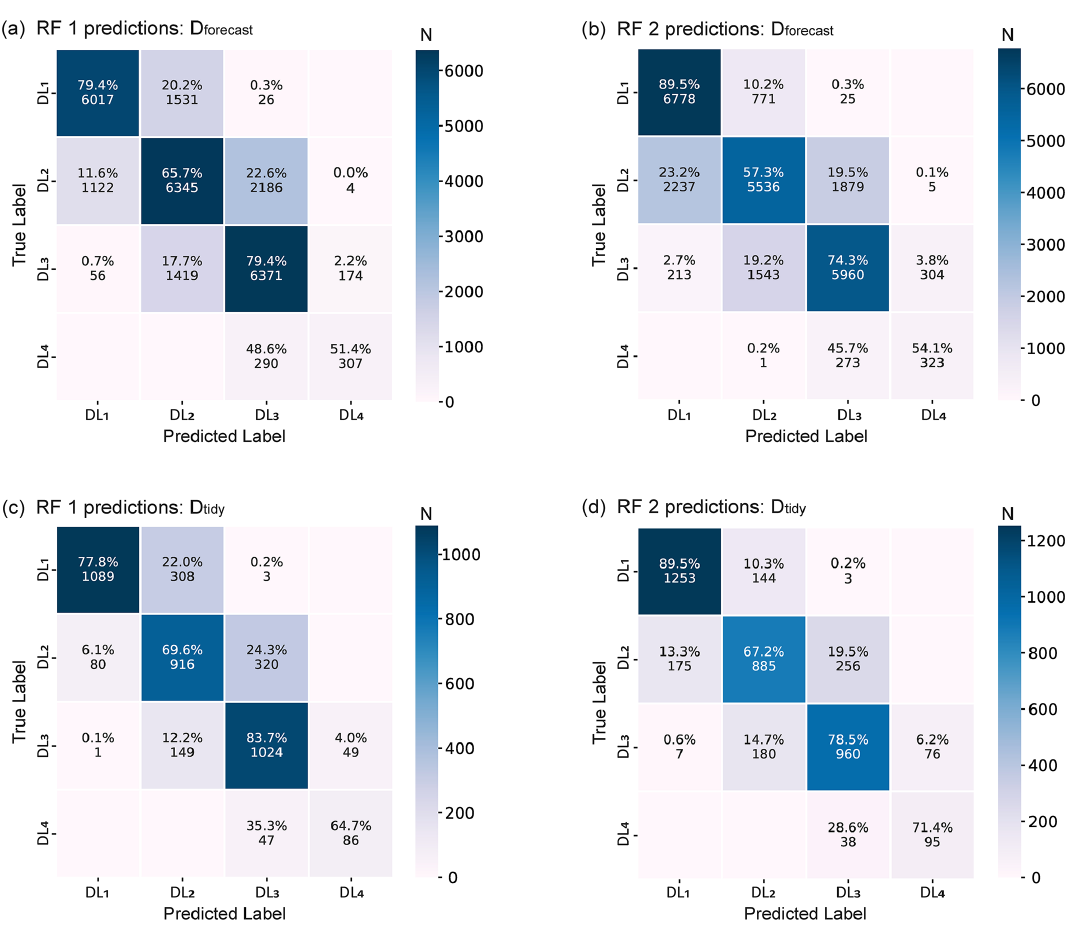
Figure 6. Confusion matrices of the two random forest models, RF 1 (trained with D forecast ) and RF 2 (trained with D tidy ), applied to the test set data of (a) the forecasted danger levels and (b) the tidy danger levels of the winter seasons of 2018/19 and 2019/20. Table 1. Test set model performance scores of the two final random forest models (RF 1 and RF 2): precision (Prec.), recall (Rec.) and F1 for each danger level (DL; 2-Moderate and 3-Considerable are denoted as 2-Mod. and 3-Cons., respectively), overall accuracy (Acc.) and macro-F1 score. (a) Predictions RF 1 vs. D forecast (ground truth). (b) Predictions RF 2 vs. D forecast (ground truth). (c) Predictions RF